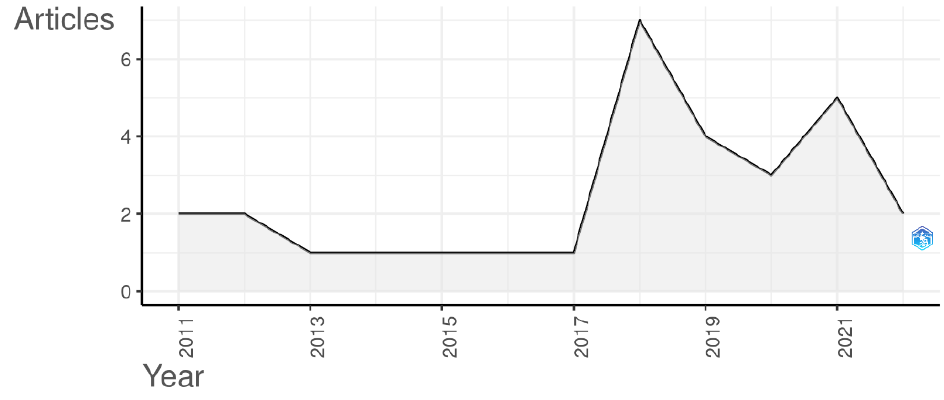
Fig. 5. Number of papers from four databases published between 2011 and